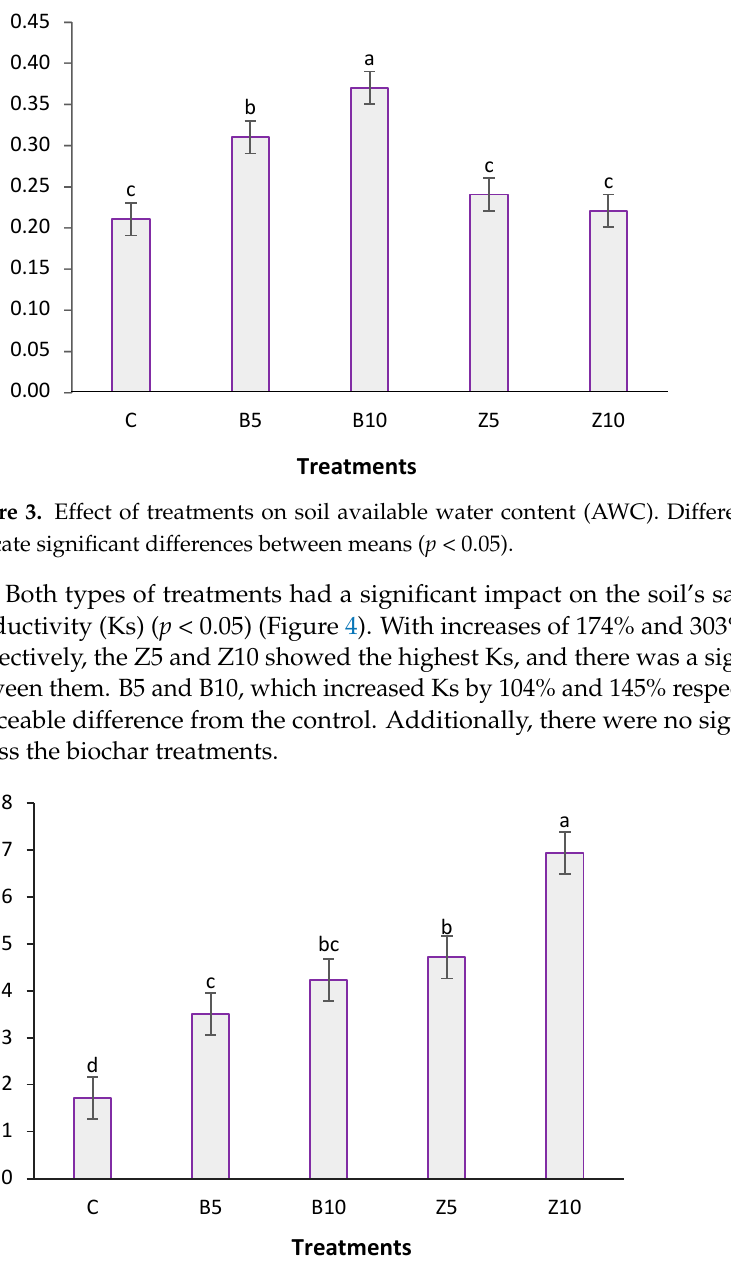
Figure 4. Effect of treatments on soil saturated hydraulic conductivity (Ks). Different lowercase letters indicate significant differences between means ( p < 0.05).